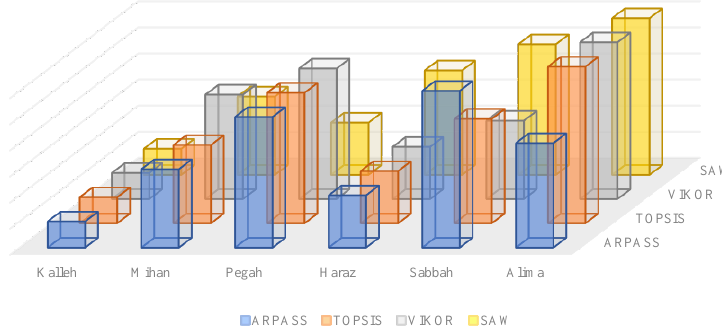
Figure 8. The comparative analysis for the first cheese suppliers of ARASS, TOPSIS, VIKOR, and SAW.